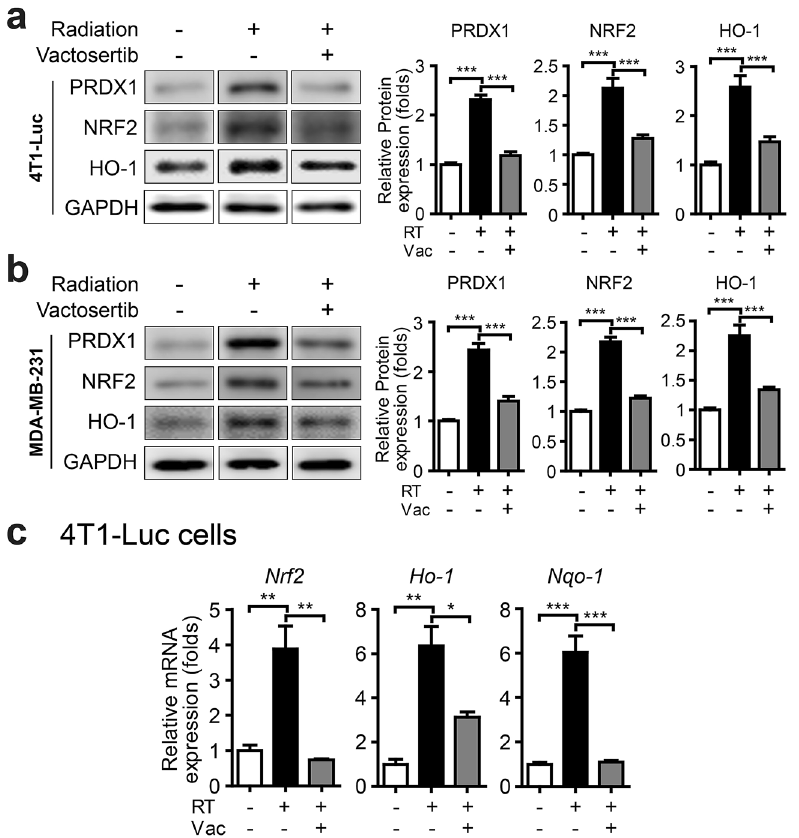
Figure 4. Vactosertib blocks radiation-induced ROS markers. ( a, b ) Protein expression of PRDX1, NRF2, HO-1 in 4T1-Luc cells ( a ) and MDA-MB-231 cells ( b ) by western blot analysis (Band was normalized by GAPDH.). The band image was cropped after selecting a representative blot, and the sample was derived from the same experiment. Original blots are presented in Supplementary Fig. 1. ( c ) mRNA expression of Nrf2 , Ho-1 , and Nqo- 1 in 4T1-Luc cells (Relative mRNA expression was normalized by Ppia